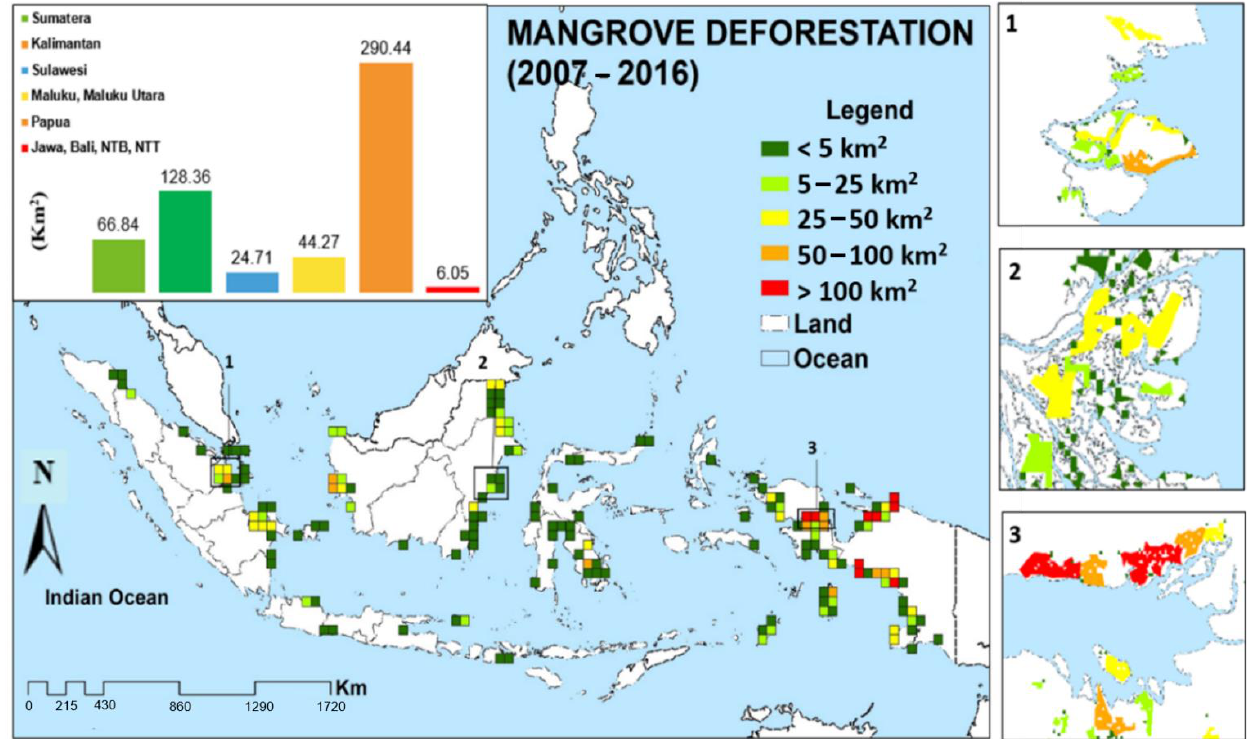
Figure 11. Distribution of mangrove deforestation in Indonesia during 2007–2016 with a grid visualization of 1 km.